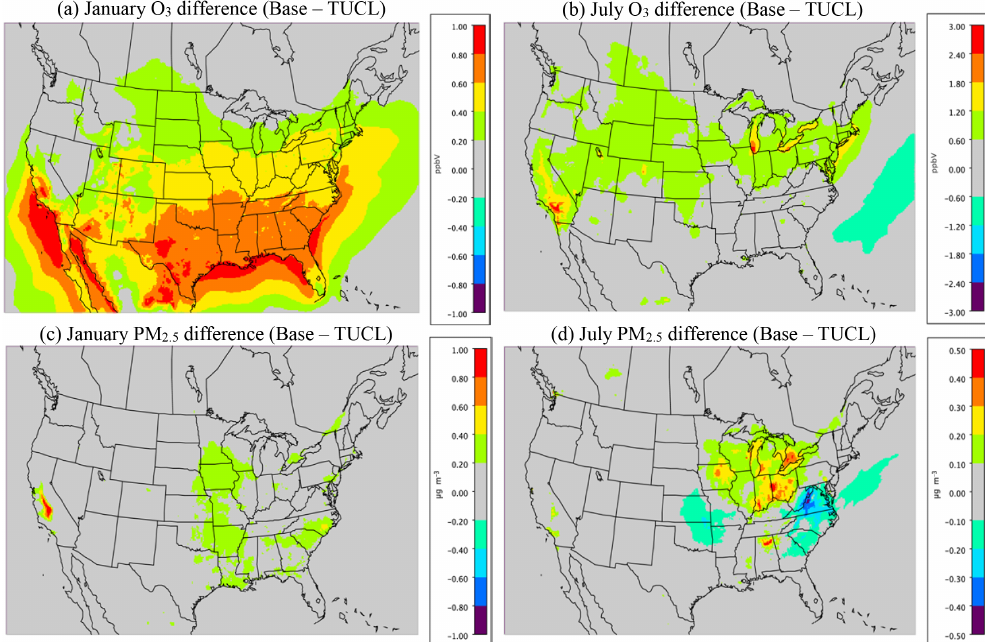
Figure 5. Difference in the monthly average O 3 for (a) January and (b) July and PM 2 . 5 (with organic matter mass removed) for (c) January and (d) July between CMAQv5.1_Base_NEIv2 and v5.1_TUCL (CMAQv5.1_Base_NEIv2–CMAQv5.1_TUCL). O 3 plots are in units of parts per billion by volume (ppbv) and PM 2 . 5 plots are in units of micrograms per cubic meter (µgm − 3 ). Note that the scales for each plot can